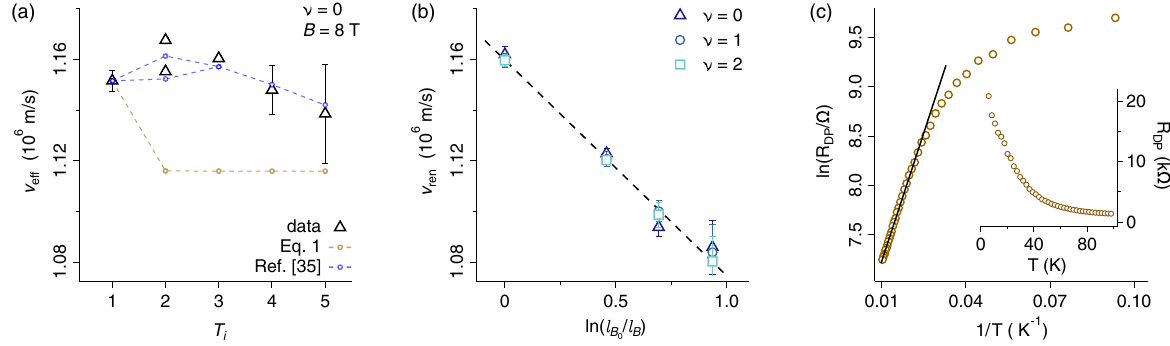
FIG. 5. Effective velocity, renormalized velocity, and activated transport. (a) Transition energies parametrized as effective velocities Δ E mea s ð T v = Δ E calc ð T v ¼ 10 6 ; μ ¼ 0 (cid:4) at ν ¼ 0 . The dashed lines predict v i Þ i Þ ½ eff ¼ single-particle model of Eq. (1) including a finite Dirac mass, while the blue lines are calculated using the many-particle theory of Ref. [35]. (b) Renormalized Fermi velocity v ren , extracted from fits to the theory of Ref. [35], plotted vs the logarithm of resulting linear dependence is the magnetic-field equivalent of the zero-field velocity renormalization in graphene [20,22,46,47]. (c) Arrhenius plot of the device resistance at charge neutrality and zero magnetic field. The slope implies a gap of 15.0 meV. The inset shows the measured resistance vs